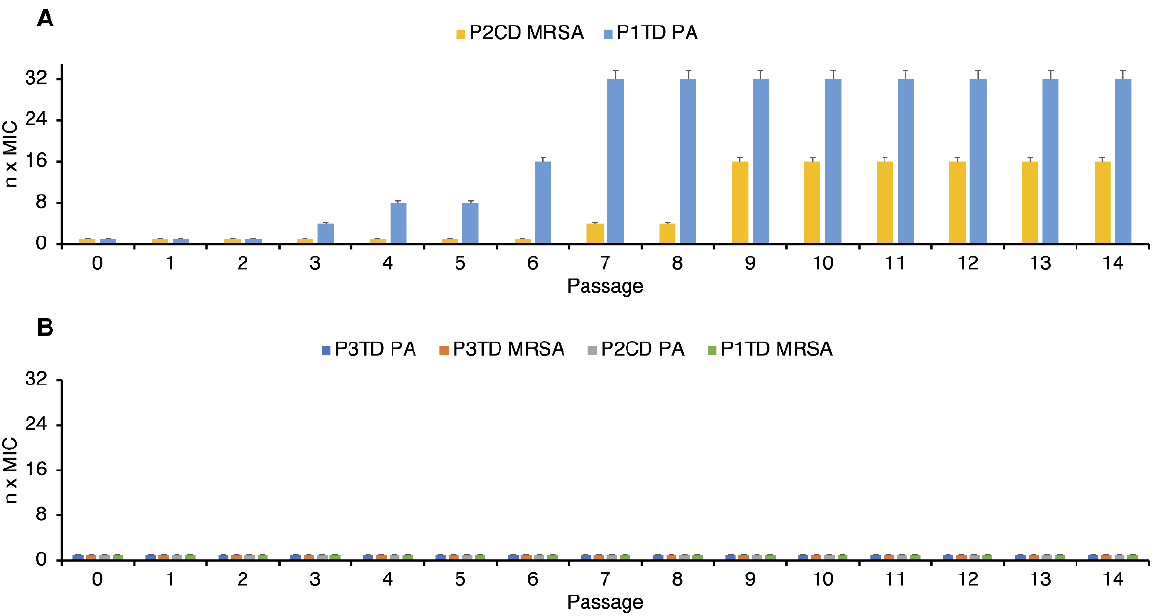
Figure 8. Propensity of Staphylococcus aureus and Pseudomonas aeruginosa (PA) to develop resistance to deprotected polytriazoles P1TD, P2CD and P3TD as a function of the number of passages: ( A ) Resistance appears; ( B ) No resistance appears. n MIC: n was the number by which the MIC value was multiplied in each passage. Standard deviation is plotted with error bars in the graphs.